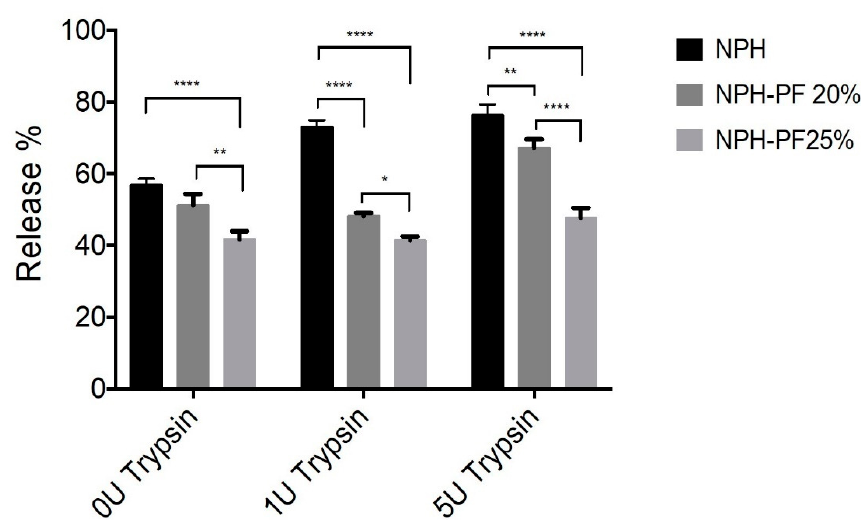
Figure 8. Comparison of the insulin release in vitro at t = 6 h: NPH, NPH-PF127 (20%), and NPH-PF127 (25%) without and with (1–5 U/mL) trypsin. Values represent the mean ± S.D. ( n = 3). Statistically significant differences (**** p < 0.0001, ** p < 0.001, and * p < 0.01) in the % release values (at t = 6 h) between each paired group were obtained using Tukey’s post hoc test.